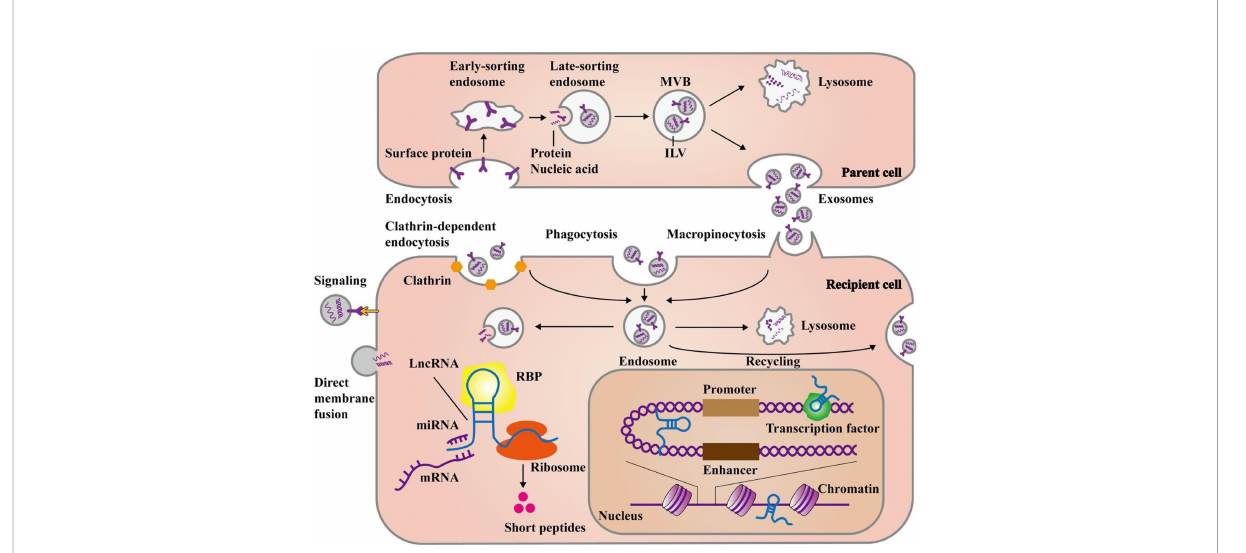
FIGURE 2 The main steps of biogenesis and release of exosomal lncRNAs. Exosome formation commences with the development of early and late-sorting endosomes by endocytosis of plasma membrane proteins. This process is followed by the formation of intraluminal vesicles (ILVs) from the late- sorting endosomes via the inward budding of their membrane which encapsulate macromolecules such as proteins, DNAs, and RNAs. Eventually, late-sorting endosomes develop into multivesicular bodies (MVBs) that secrete ILVs as exosomes. The MVBs can fuse with lysosomes for the degradation of their contents. Exosomes can either directly transmit their cargo to recipient cells or release it after fusion with the recipient cell plasma membrane. Moreover, exosomes may create endosomes by three main pathways, namely, endocytosis, macropinocytosis, or phagocytosis. In response to cellular requirements, the endosomes may release their exosomal contents, combine with lysosomes to be degraded, or fuse with cell membrane for recycling the exosomes. Then, the release of exosomal lncRNAs leads to the modulation of cell functions through several mechanisms. They can in fl uence gene expression at post-transcriptional levels via targeting miRNAs, mRNAs, or proteins in the cytoplasm. Additionally, some lncRNAs have the potential for encoding short peptides. On the other hand, lncRNAs can play a role in the nucleus,